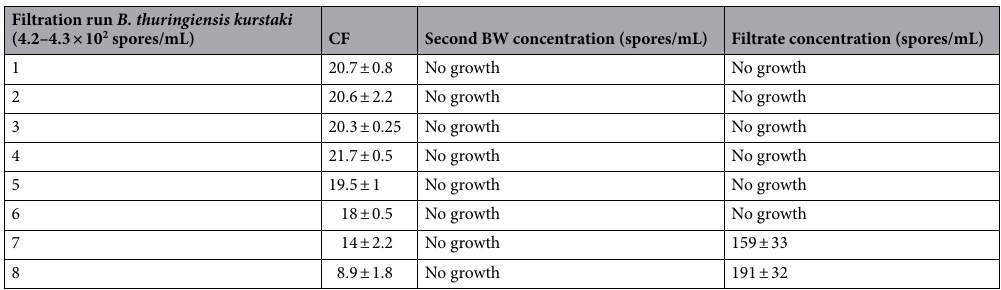
Table 4. Concentration factors of B. thuringiensis kurstaki spores achieved for backwashing of the same FG filter and concentration of spores in filtrates obtained with bleach-free filtration runs (The limit of detection at 10 spores/mL for 100 µL